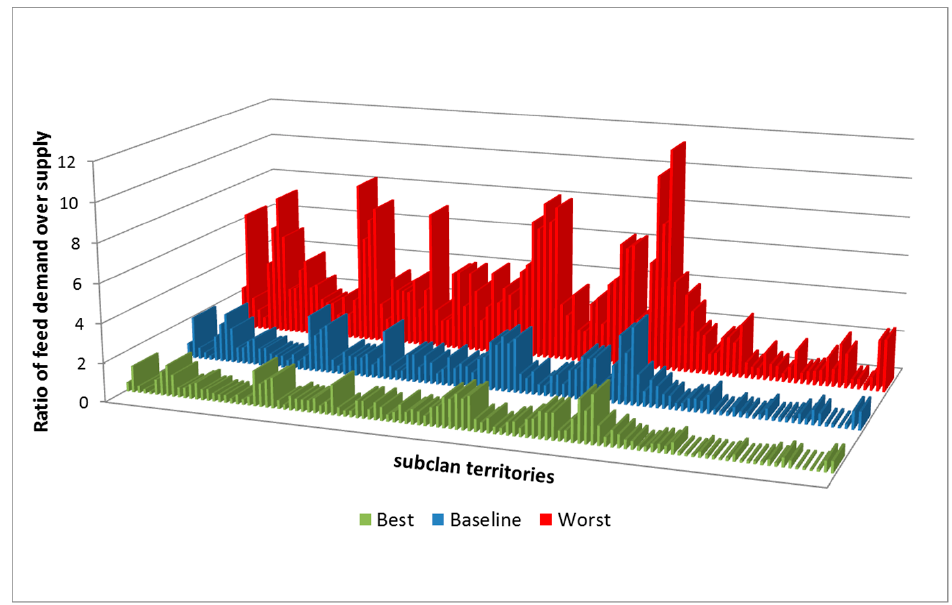
Figure 15. Results of sensitivity analysis. Ratio feed demand over supply for ’Best’, ‘Baseline’ and ‘Worst’ scenario.